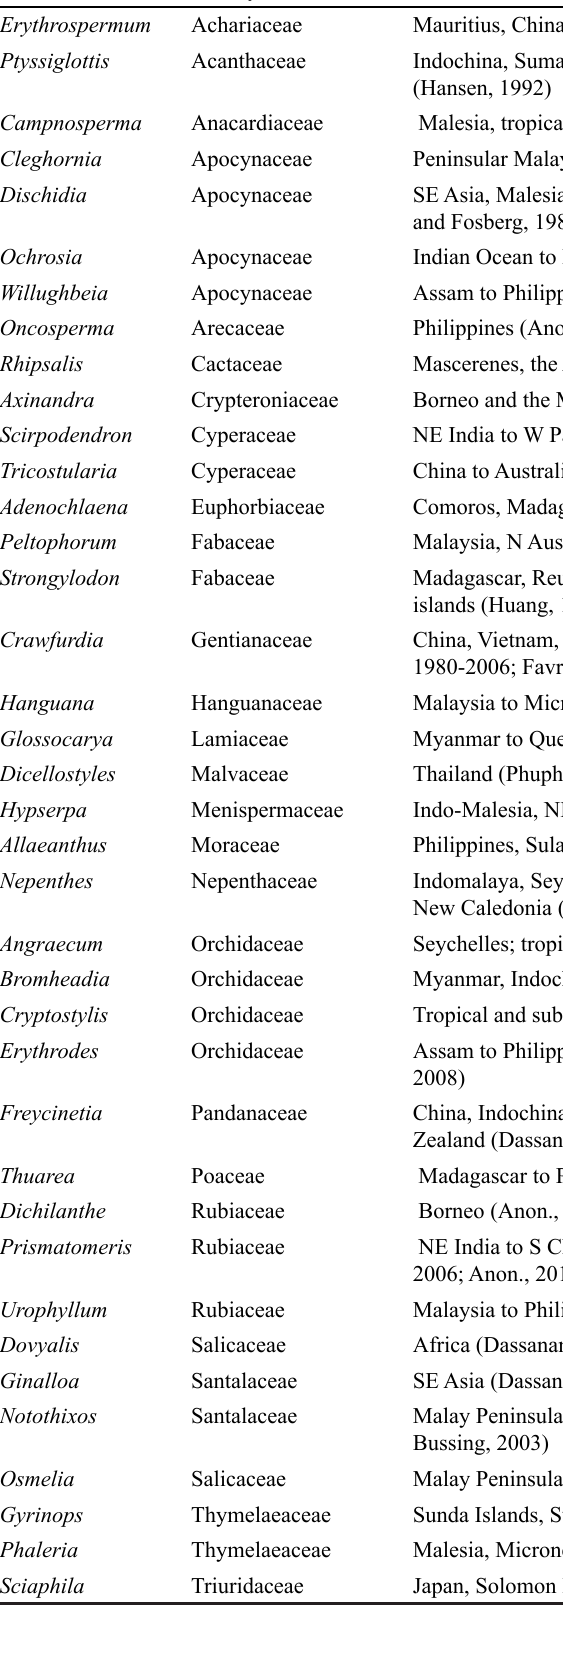
Table 1: Genera of plants occurring in Sri Lanka and elsewhere other than the peninsula of India.